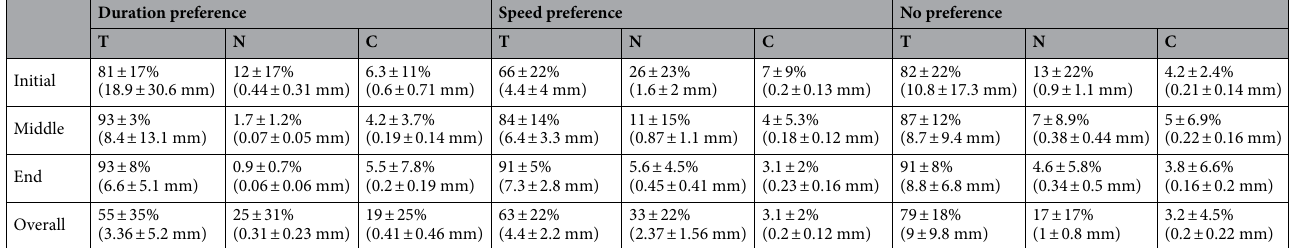
Table 2. TNC-cost analysis results. In the table are reported the results obtained from the TNC-Cost analysis for each group (Duration Preference, Speed Preference, and No-Preference). Results for the individual costs are reported in the relevant columns (T = Tolerance, N = Noise, and C = Covariance) and are expressed as relative weight for each cost (in percentage) as well as the measured cost in mm (in parenthesis). Each row corresponds to the relative segment of the performance (initial, middle, and end), each composed of 16 revolution. The last row reports values of the overall performance (i.e., 48